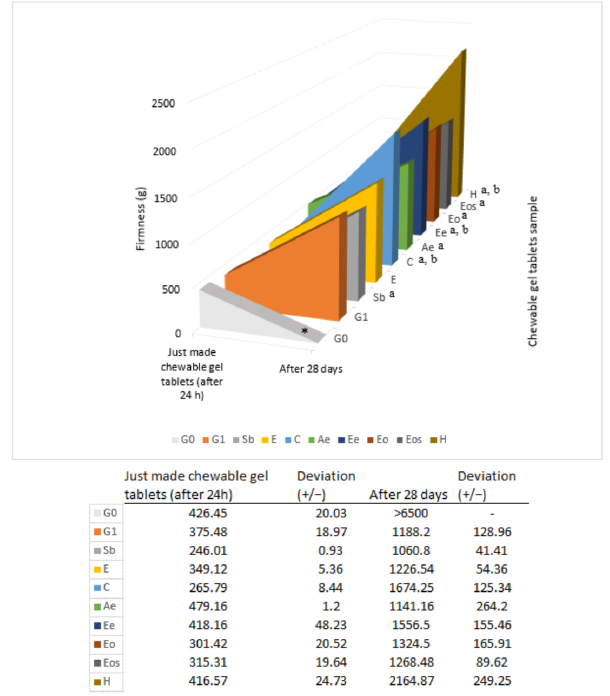
Figure 7. Firmness changes in chewable gel tablets after 28 days kept at room temperature in an open plastic bag. * Device did not measure value after 28 days, it was higher than 6500 g, a statistically significant change after 24 h vs. G1; b—statistically significant change after 28 days vs. G1, p < 0.05, n = 8.